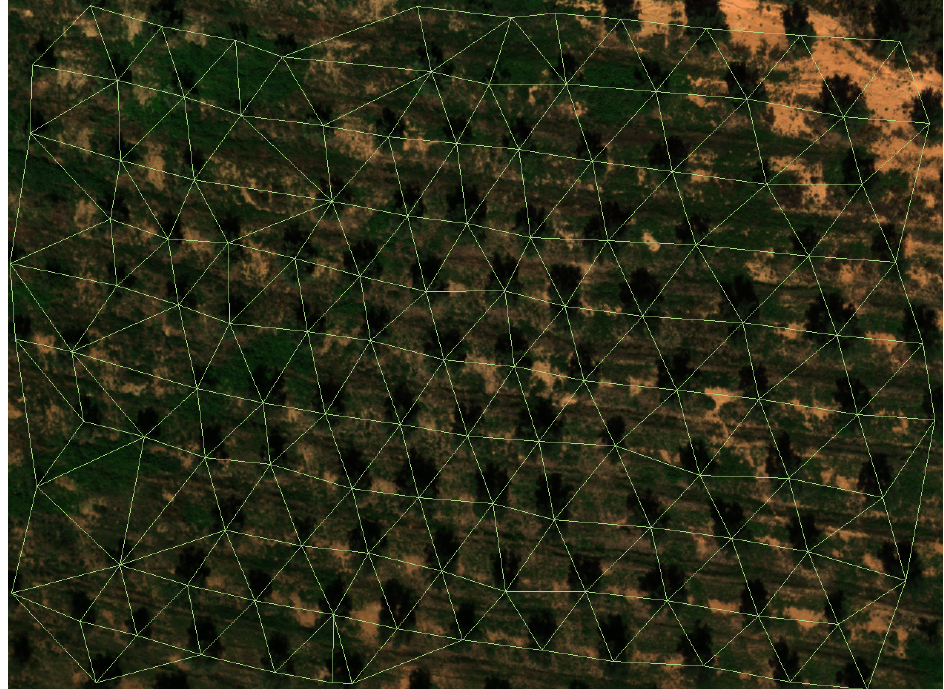
Figure 7. Delaunay triangulation using the coordinates of the olive tree canopies from capture 0, obtained with the optimal combination of parameters calculated by the model whose values are 0.9, 25 and 25 for the probability threshold, the kernel size and the segmentation threshold,